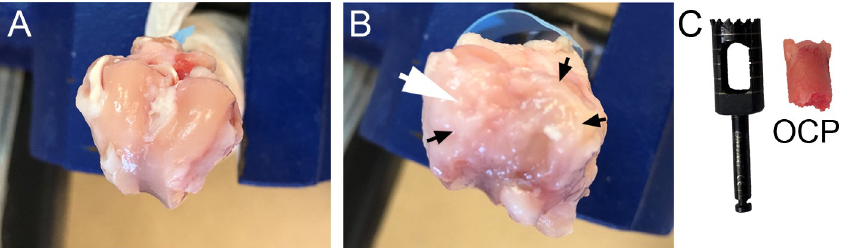
Fig 2. The appearance of the surface of uninjured (A) and injured (B) femoral condyles after twelve weeks of healing. The white arrow in B indicates the site of the osteochondral defect (OCD) made during the initial surgery. Please note the presence of the pannus-like tissue (black arrows) covering the femoral surface of the injured leg (B). C, An osteochondral plug (OCP) that encompasses the site of injury seen in panel B. A tool used to remove the plug is also